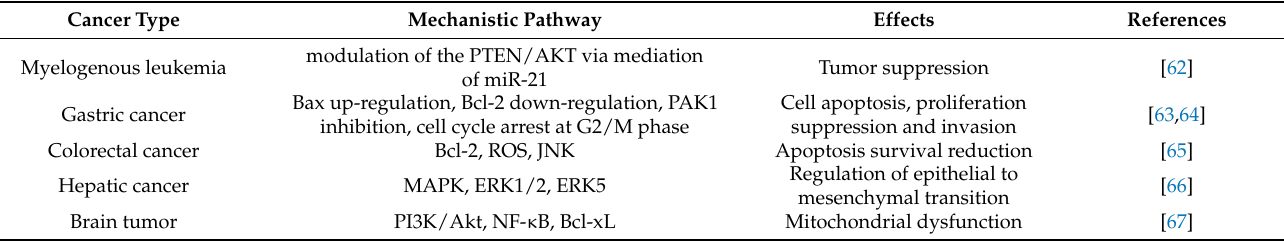
Table 1. Therapeutic potential of curcumin in various